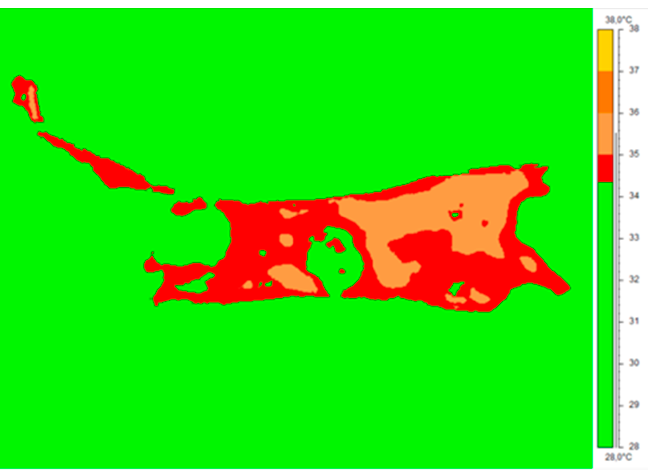
Figure 3. The isotherm area for a representative patient limb. The isotherm temperature was set as the mean temperature of the whole limb. All pixels with a temperature lower than the threshold (green color) were not counted in ROIs’ mean temperature values. Table 1. Area changes counted by thermal imaging during the three THBOT treatment periods obtained for all studied patients.